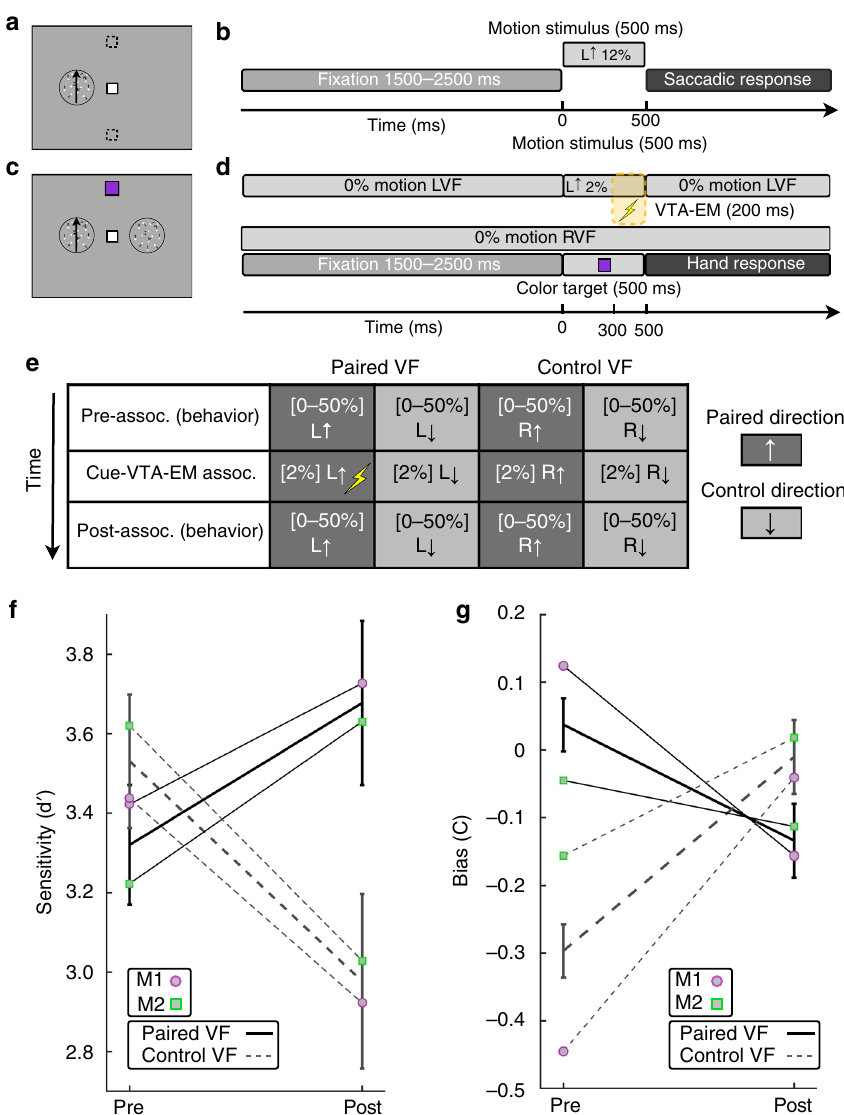
Fig. 4 Experiment 2: Pairing improves stimulus detection and increases response bias. a Example positioning of LVF random-dot motion stimulus (4° diameter, 7.5° eccentricity) during the motion discrimination task. Dashed boxes represent virtual saccade response windows that were not visible during the experiment. b Timing of individual motion discrimination trials. After a fi xation period (1500 – 2500 ms), a random dot motion stimulus (upward or downward) appeared for 500 ms. Motion direction was reported with a saccade. The coherence level (0, 2, 6, 12, 25, 50%), motion direction and VF in which the random-dot stimuli were displayed were equiprobable and randomized. c Positioning of stimuli during cue-VTA-EM association. Random-dot motion stimuli were positioned concurrently in the LVF and RVF. The color targets were identical to experiment 1. d Timing of individual trials of the cue- VTA-EM association phase. After a fi xation period (1500 – 2500 ms), a color target was shown for 500 ms concurrently with a 2% motion stimulus in one VF and a 0% motion stimulus in the contralateral VF. A hand response reported color target identity. Before and after the color target, 0% motion stimuli were shown in both VFs. Only one condition (e.g. 2% left upward) was paired with VTA-EM (300 ms after motion onset, 200 ms, 100 Hz, Methods). e Outline of one round of experiment 2. The arrows indicate direction of motion. L = left VF, R = right VF. The range of coherence levels is indicated between brackets. Parathreshold f d-prime, and g c-criterion for 0 – 25% motion stimuli was compared between pre- (40 bins per round, 100 trials/bin) and post-association (20 bins per round, 100 trials per bin, see Methods) phases. Mean values for the paired VF (solid lines) and the control VF (dotted lines) during the pre-and post-association phases were calculated for the group (black lines) and individuals (M1 — purple circle; M2 — green square). Error bars denote sem for the group. Source data are provided as a Source Data fi